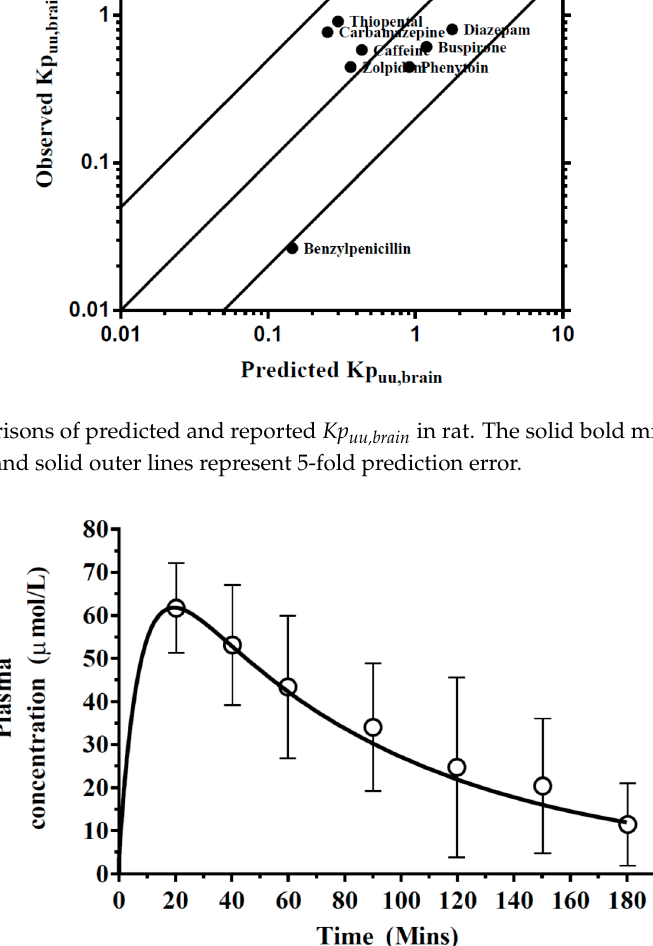
Figure 5. Simulated mean phenytoin hippocampus and frontal cortex concentration–time profiles. Simulated mean values of phenytoin-time profiles in ( A ) hippocampus and ( B ) frontal cortex after a 50 mg/kg dose of phenytoin. Open circles and errors bars represent literature reported mean and ±SD in 5 rats. The solid black line represents model prediction mean profiles and dashed lines indicated 95th and 5th percentiles.